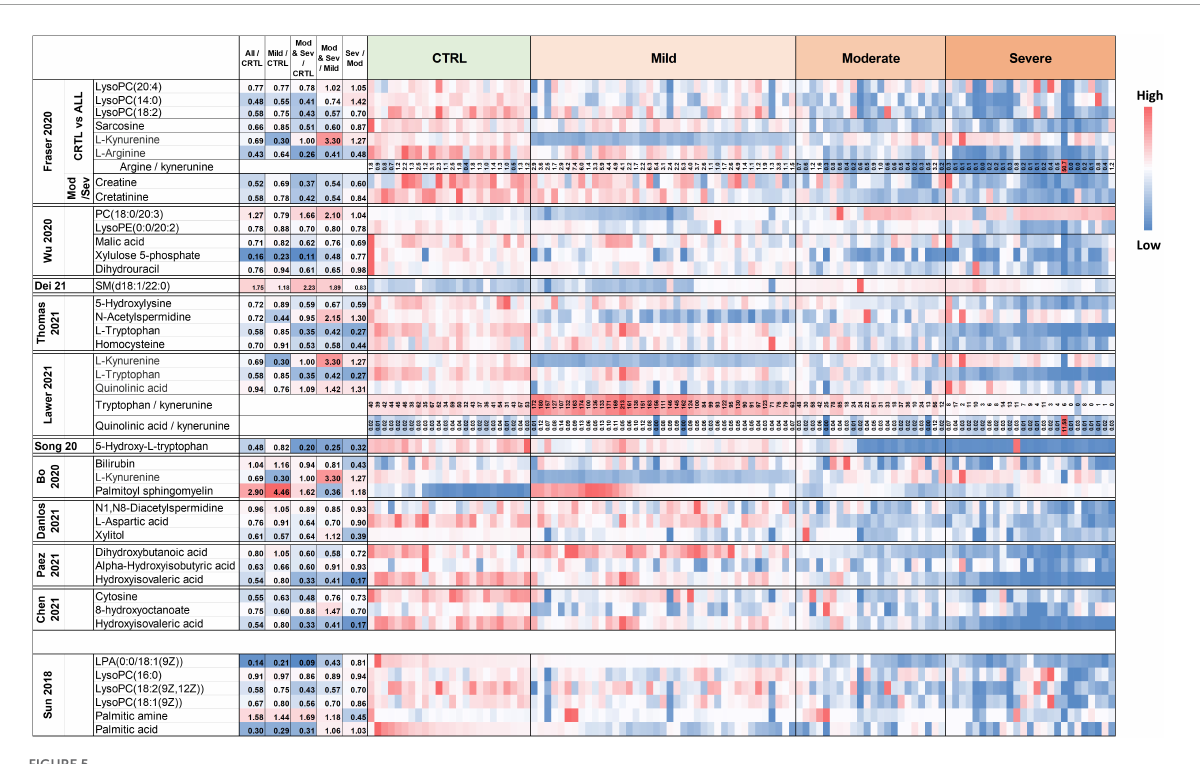
FIGURE5 Heatmap of plasma levels of published putative biomarkers of SARS-CoV-2 infection and COVID-19 severity. The values are available in Supplementary Data 5–13